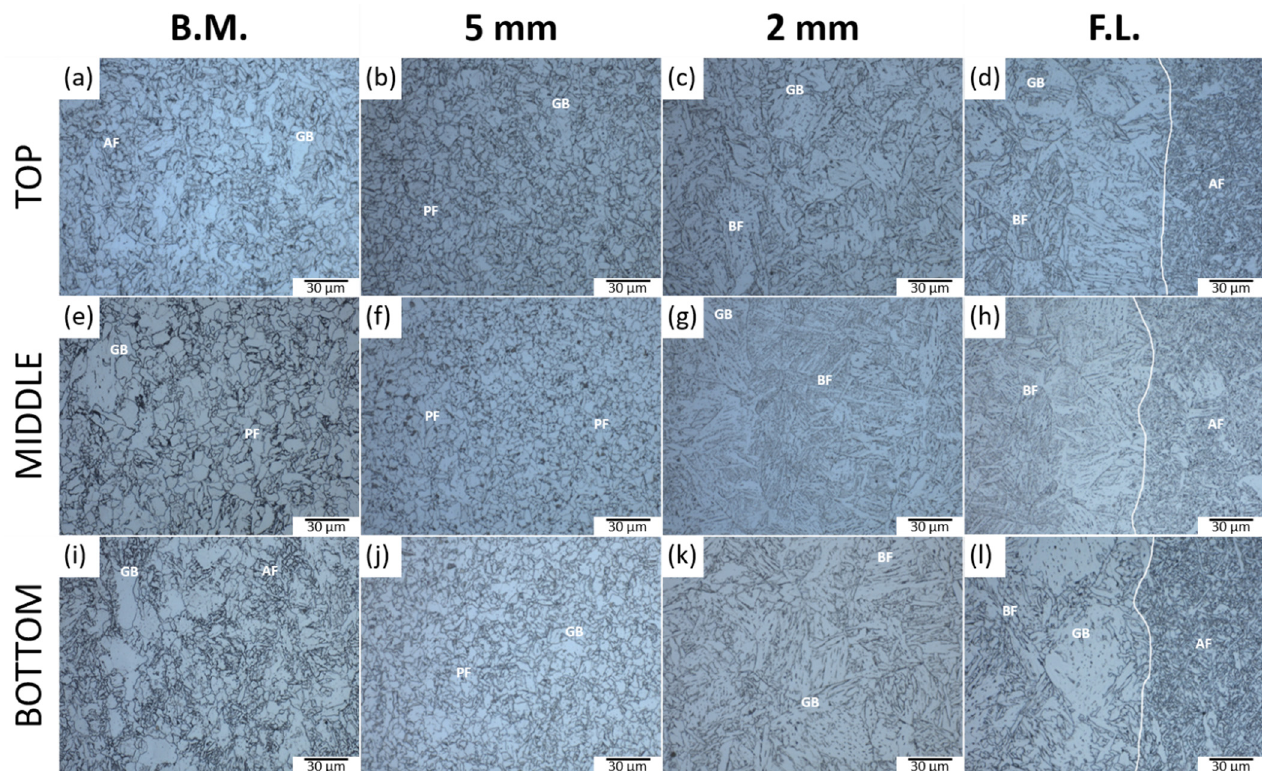
Figure 3. Optical micrographs of the base metal and HAZ: ( a ) base metal, ( b ) 5 mm from F.L., ( c ) 2 mm from F.L., ( d ) F.L. of top; ( e ) base metal, ( f ) 5 mm from F.L., ( g ) 2 mm from F.L., ( h ) F.L. of middle; ( i ) base metal, ( j ) 5 mm from F.L., ( k ) 2 mm from F.L., ( l ) F.L. of bottom.